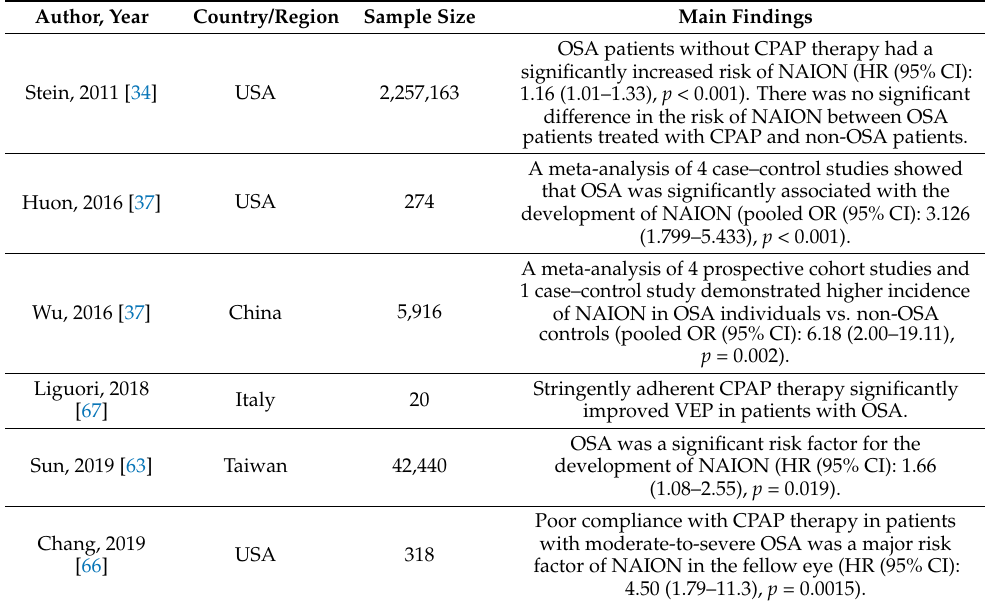
Table A2. Summary of the major studies evaluating the association between OSA and ischemic optic neuropathy.